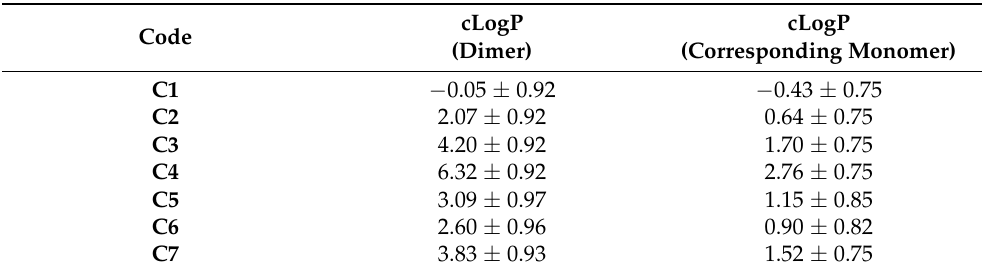
Figure 7. Cytotoxicity (IC 50 ) vs. adjusted retention time (tR’): ( a ) USCL—parent molecules (series A ); ( b ) gemini lipopeptides with L-lysine amide spacer (series B ); ( c ) gemini lipopeptides with L-cystine diamide spacer (series C ). Arrows indicate that IC 50 is above the applied concentration range. Table 3. Calculated LogP values for series C and the corresponding monomers. cLogPs were calculated with ACD/ChemSketch 2020.1.2.